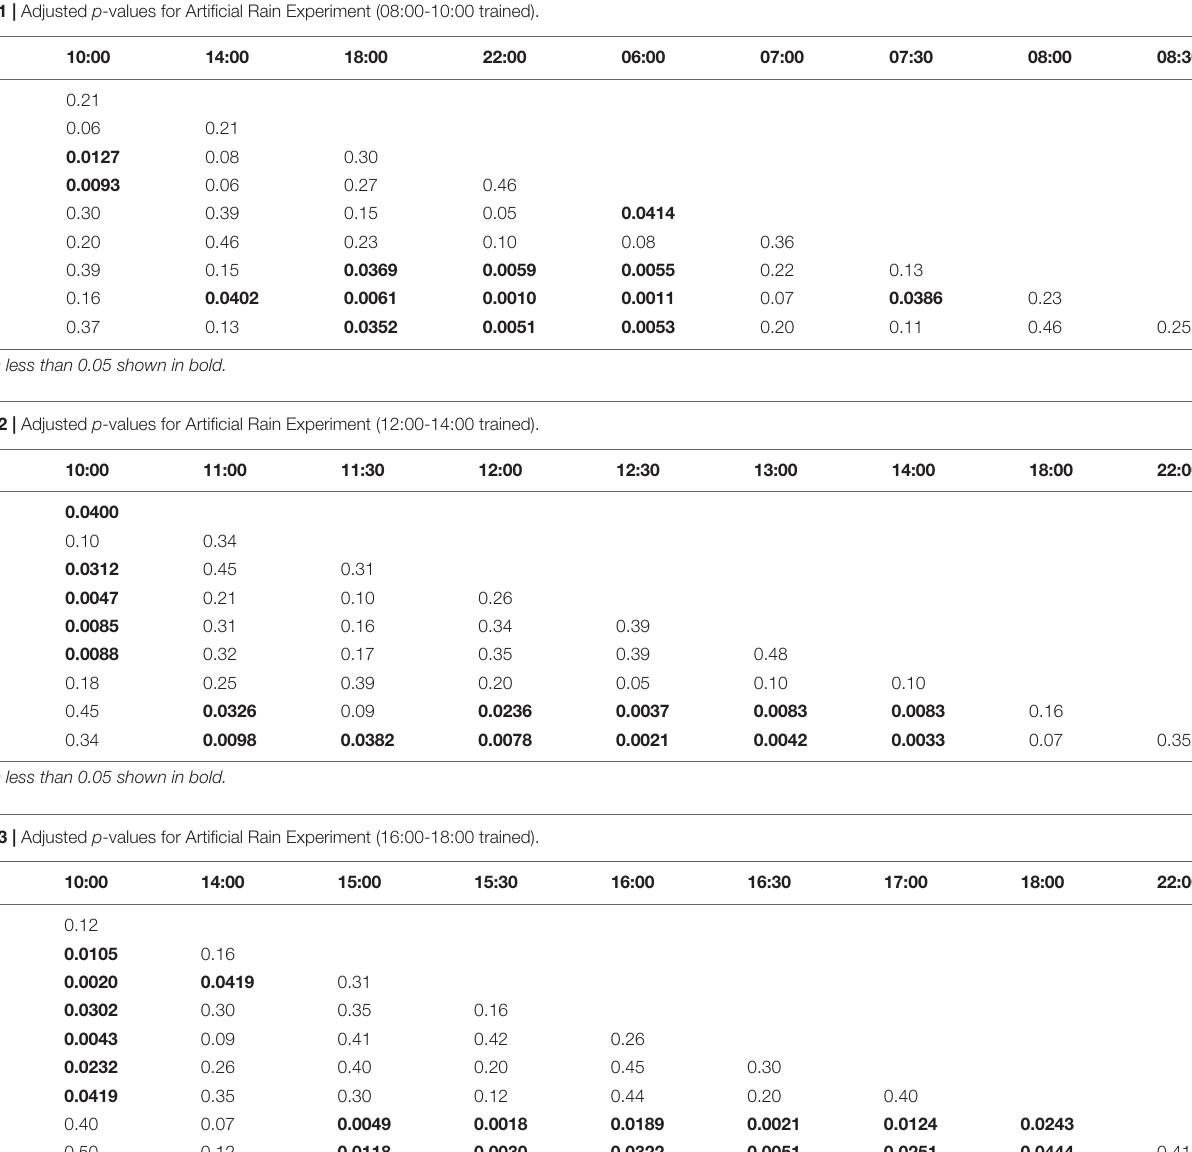
TABLE 1 | Adjusted p -values for Artificial Rain Experiment (08:00-10:00 trained).